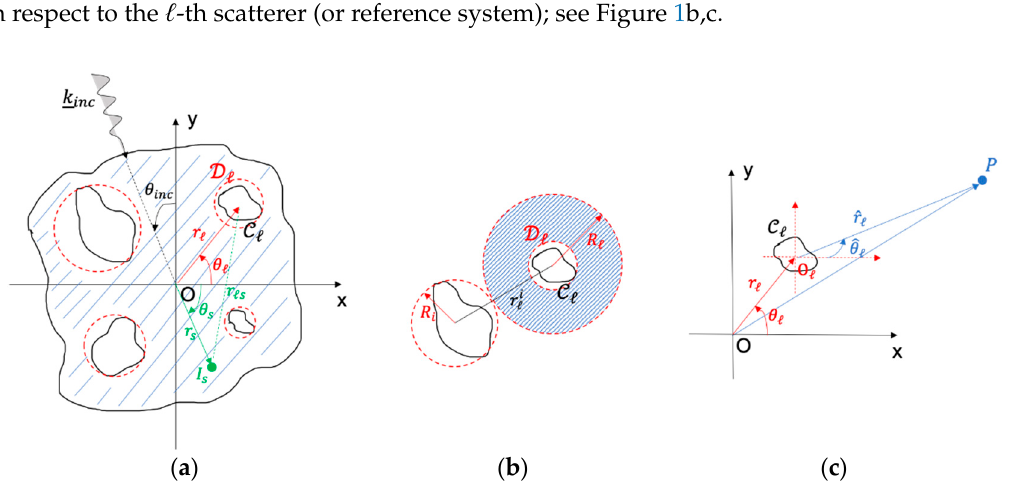
Figure 1. Geometrical sketch and notation involved in the scattering matrix method (SMM). In ( a ) both the cases of plane wave and line current incident fields are depicted. In ( b ) an enlargement of two generic scatterers is depicted to define reciprocal variables and highlight the annulus wherein the scattered field can be evaluated through the modal expansion. In ( c ) the coordinates of the observation point are defined with respect to the generic ℓ -th reference system.